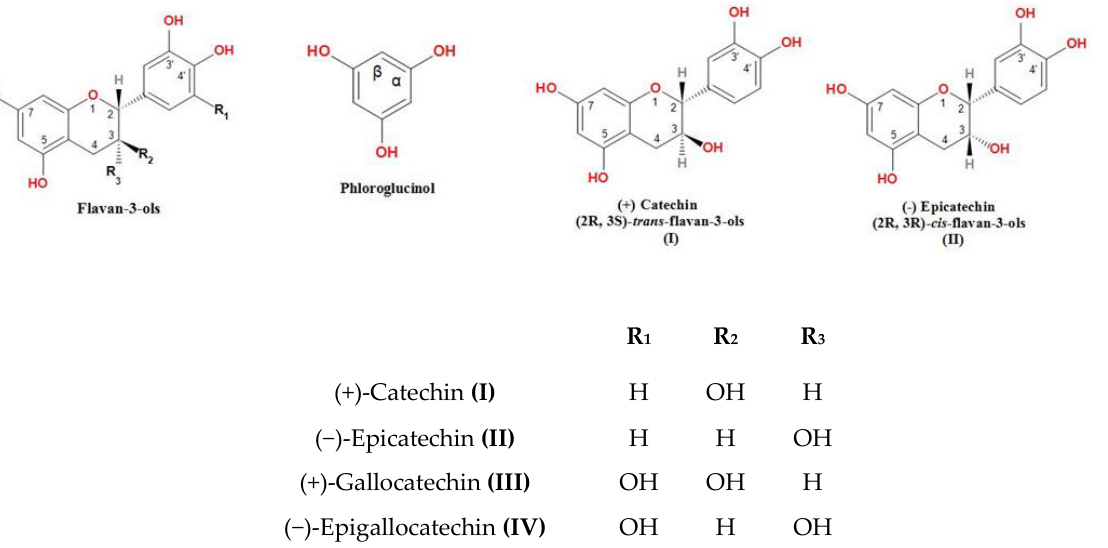
with retention times (Rt) of 15.31–48.71 min. Similar trends for above compounds were observed in Vicia faba [25].